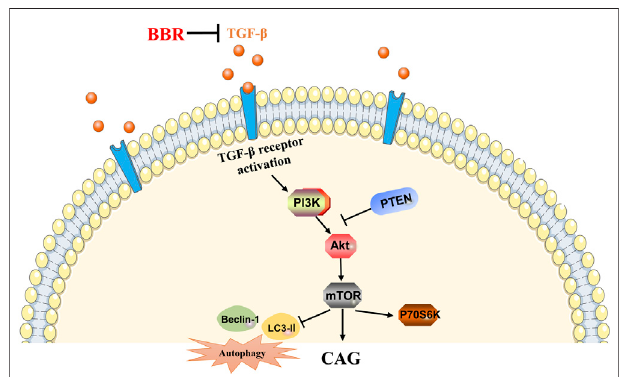
FIGURE 9 | Mechanism of BBR in improving CAG induced by MNNG. → , activate; ┤ ,